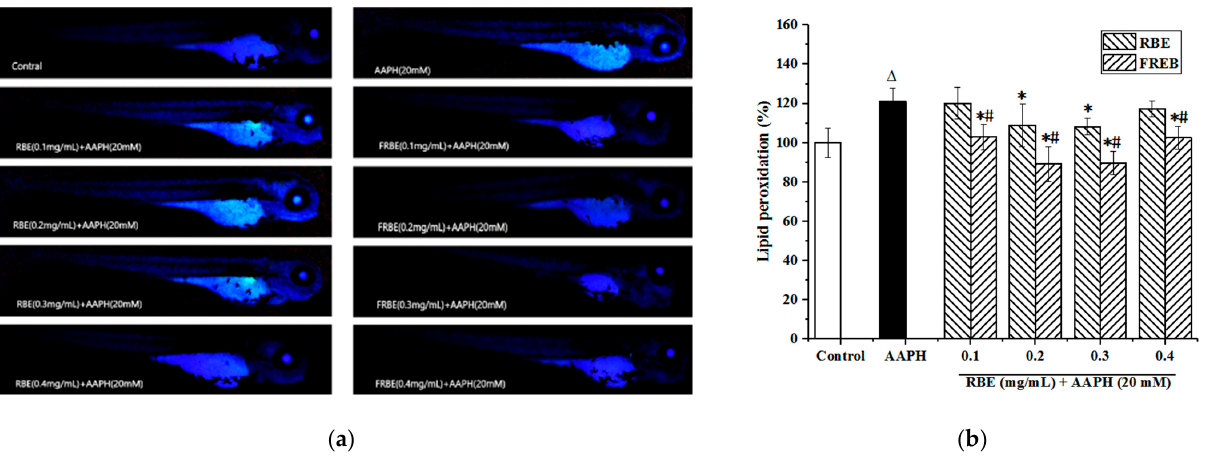
Figure 3. Protective effect of RBE and FRBE on AAPH-treated lipid peroxidation rate in zebrafish. ( a ) Lipid peroxidation levels were measured by image analysis and fluorescence microscopy; ( b ) Lipid peroxidation levels were measured using Image J software. Experiments were performed in triplicate, and the data are expressed as the means ± SE; ∆ p < 0.05 compared to the control group; * p < 0.05 compared to the AAPH-treated group; # p < 0.05 for the comparison between RBE and